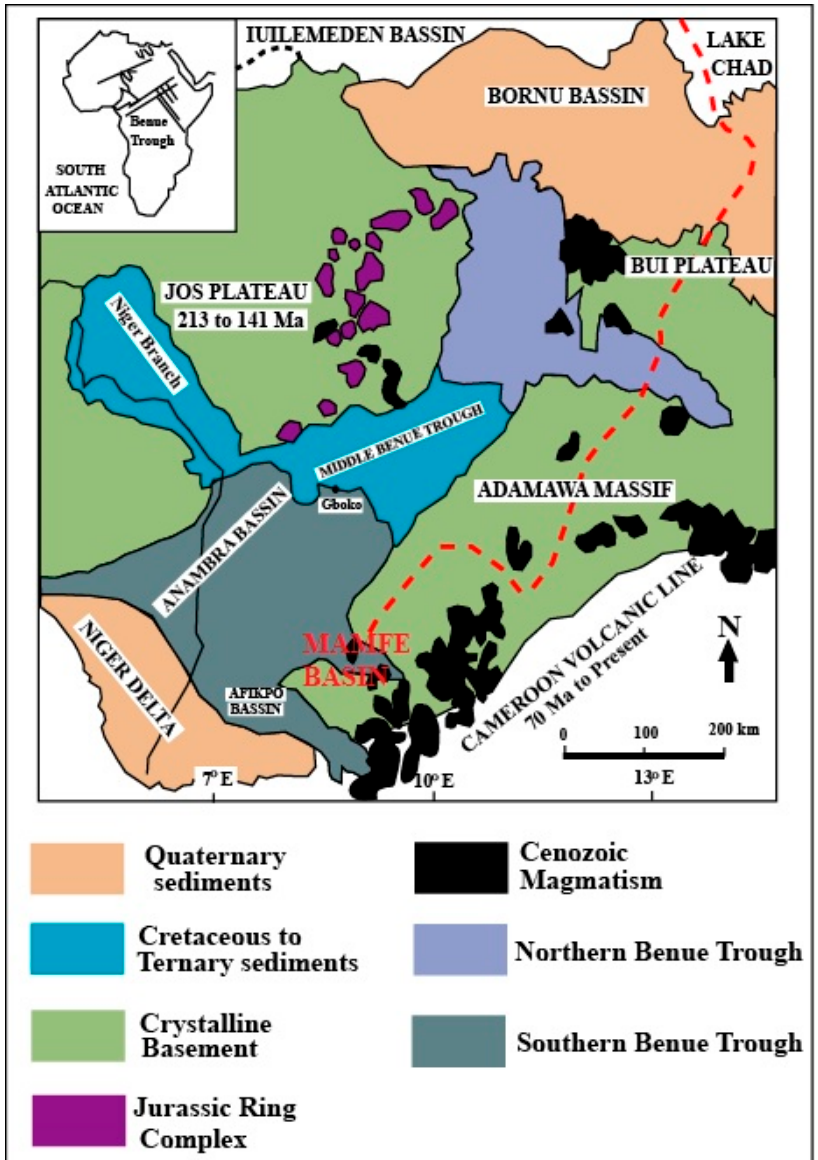
Figure 9. Geological sketch map of the Benue Trough (after [88]).